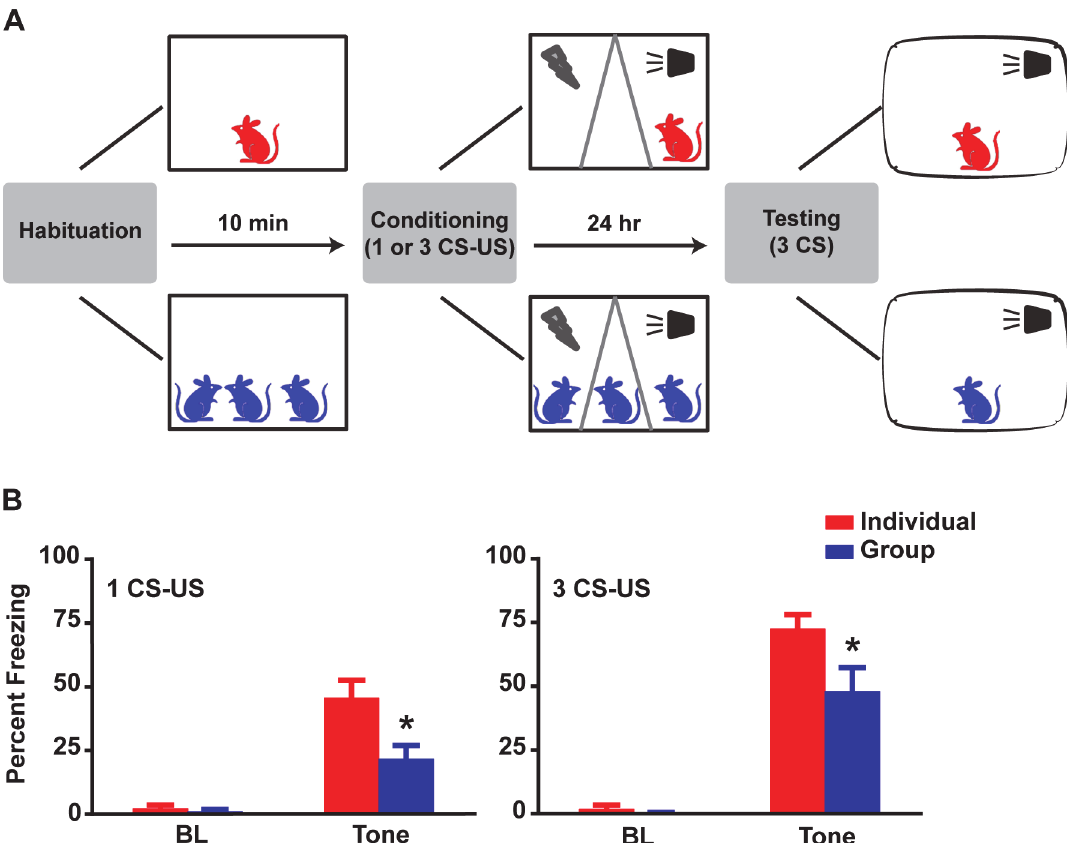
Fig 1. Group conditioning causes a robust reduction in subsequent fear expression. (A) Schematic: rats are divided between Individual and Group conditions. After a 10-min period, a transparent insert is placed and rats are assigned to 1 of 3 compartments. A single or three tones (CS) co-terminating with a footshock (US) are delivered. Twenty-four hours later, the rats are exposed to three CS presentations in a different context for LTM testing. (B) Group rats freeze significantly less than Individuals during CS presentation while maintaining similar low levels of Pre-CS baseline (BL) freezing. Two-way Repeated Measures (RM) ANOVA revealed an effect of condition (Individual or Group), F (1, 34) = 8.93, p < 0.01, and an interaction (BL x CS [average of 3]), F (1, 34) = 6.12, p < 0.05. Post-hoc tests revealed no differences for BL, p > 0.1, and a robust reduction in Group CS freezing, p < 0.001. This was replicated in a LTM test for 3 CS-US deliveries during conditioning. Two-way RM ANOVA revealed an effect of condition, F (1, 31) = 5.05, p < 0.05, and an interaction, F (1, 31) = 4.17, p < 0.05. Post-hoc tests revealed no differences for BL, p > 0.1, and a significant reduction in Group CS freezing, p < 0.01. Data presented as mean + sem.